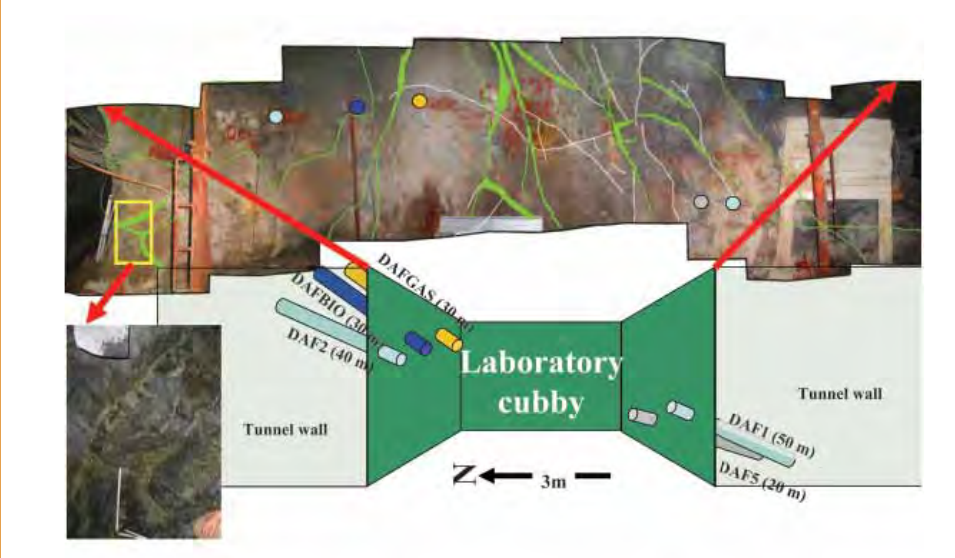
Figure 3. Three-dimensional view into laboratory cubby within Pretorius fault zone in level 118 (site 8, Fig. 2A). Panoramic composite photo (above) displays segments of Pretorius fault fi lled with sintered cata- clasite (light green with detail on lower left). Heads of fi ve boreholes are marked in various colors that cor- respond to their 3-D presentation in schematic view below.